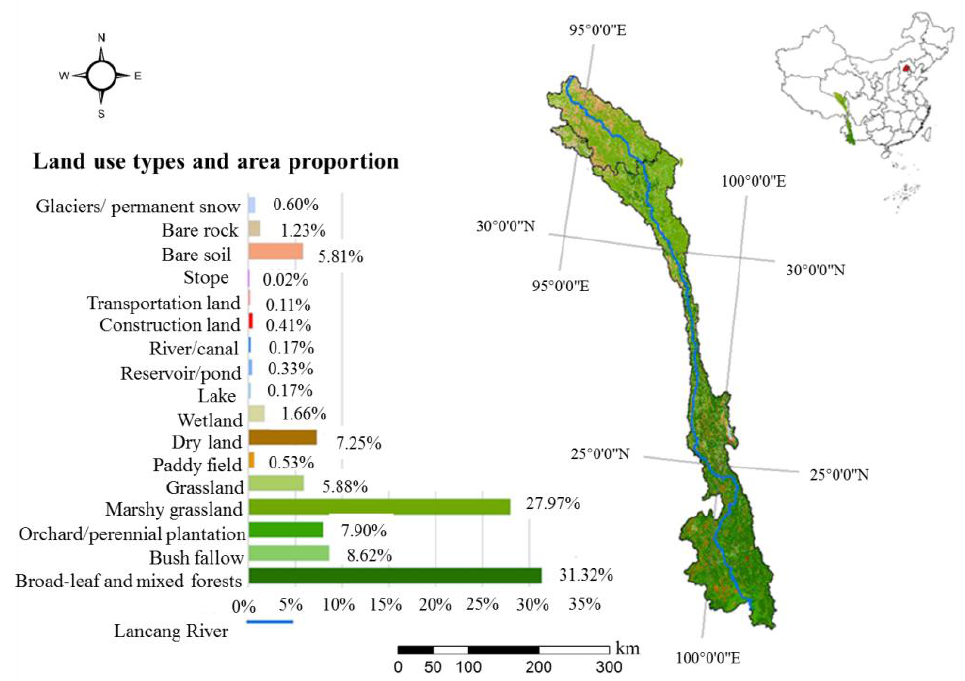
Figure 1. Location and land use type distribution of study area.